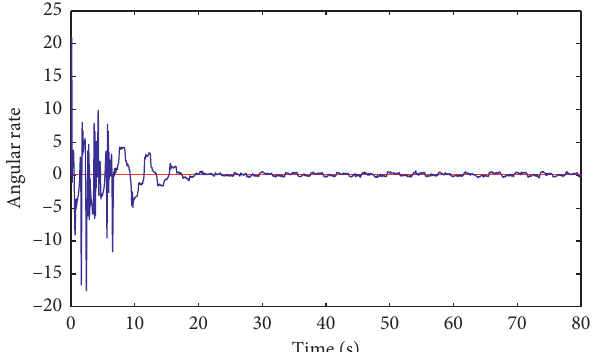
Figure 18: Adaptation of angular velocity using conventional fast TSCM.